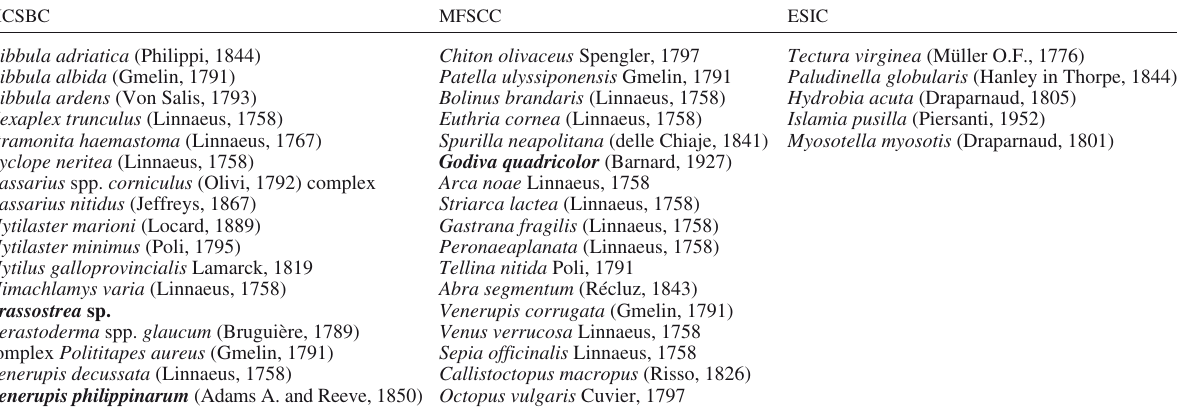
Table 4. – Summary of the commonest species observed in both clusters (MCSBC), the most frequently observed species exclusive to the Channel Cluster (MFSCC) and exclusive species of the Inner Cluster (ESIC), listed in systematic order within each cluster. Bold : alien species in the Italian territorial seawaters (Crocetta 2012, Crocetta et al.